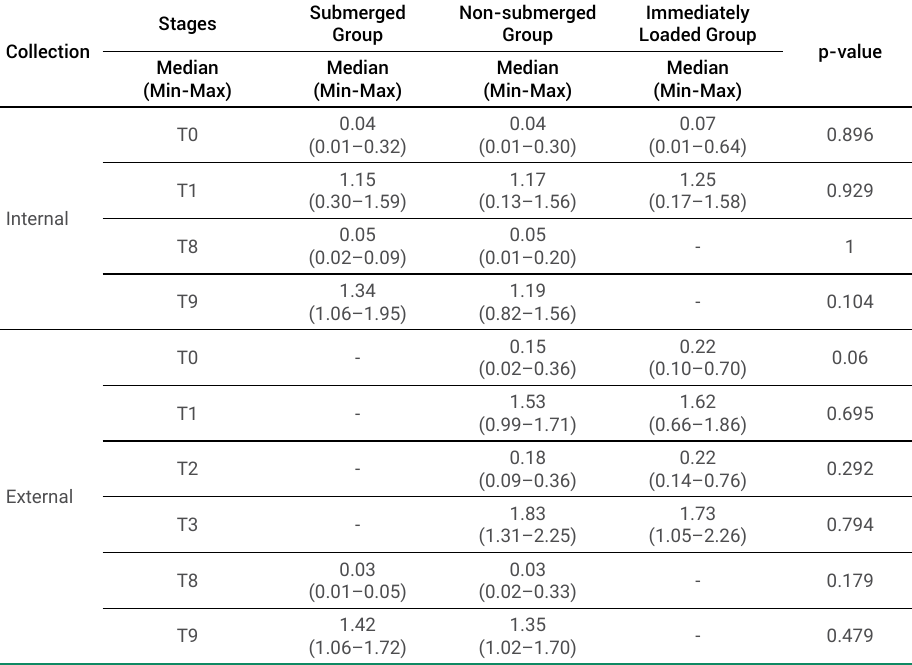
Table 2. Spectrophotometric analysis of optical density comparing the studied groups at each